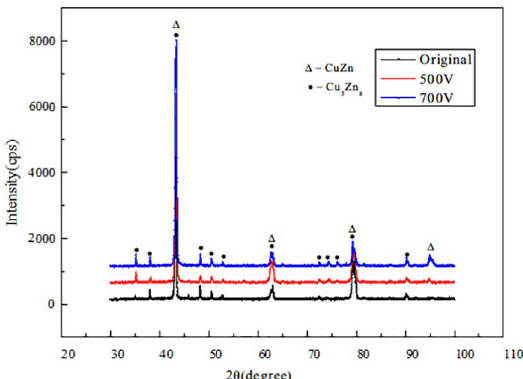
Figure 8. The XRD analysis of the phase structure of samples without corrosion